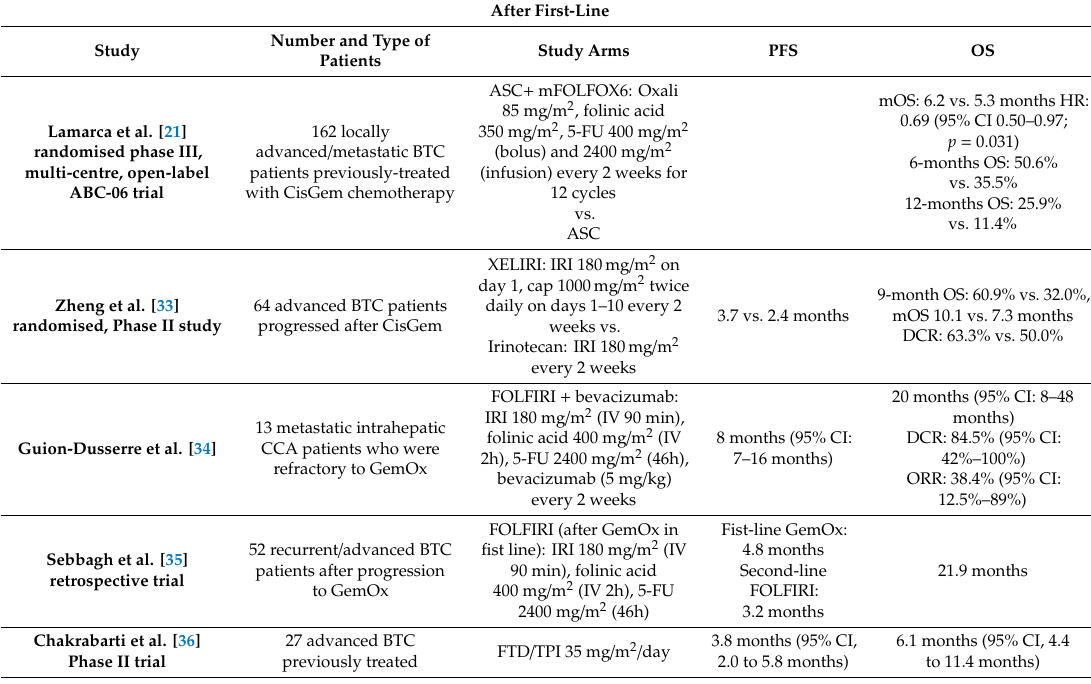
Table 3. Summary of treatments in advanced